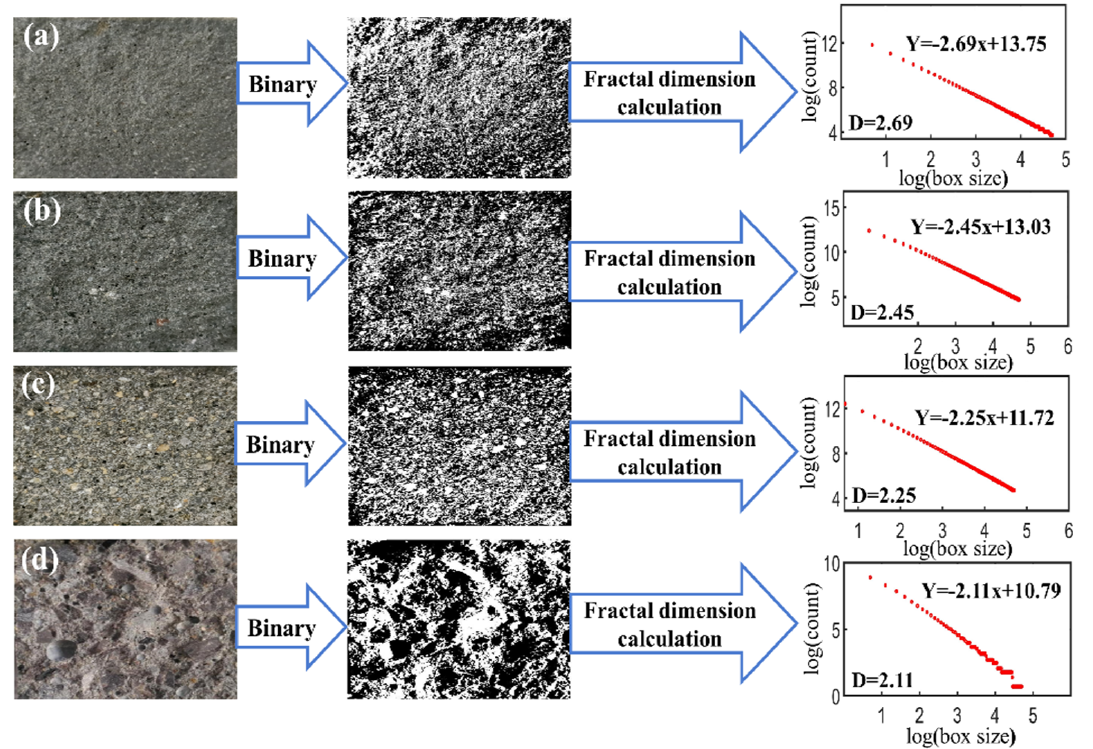
Figure 9. Binarization of image and fractal dimension calculation ( a ) ITS sand concrete, ( b ) GTS sand concrete, ( c ) RS sand concrete, ( d ) Ordinary concrete.